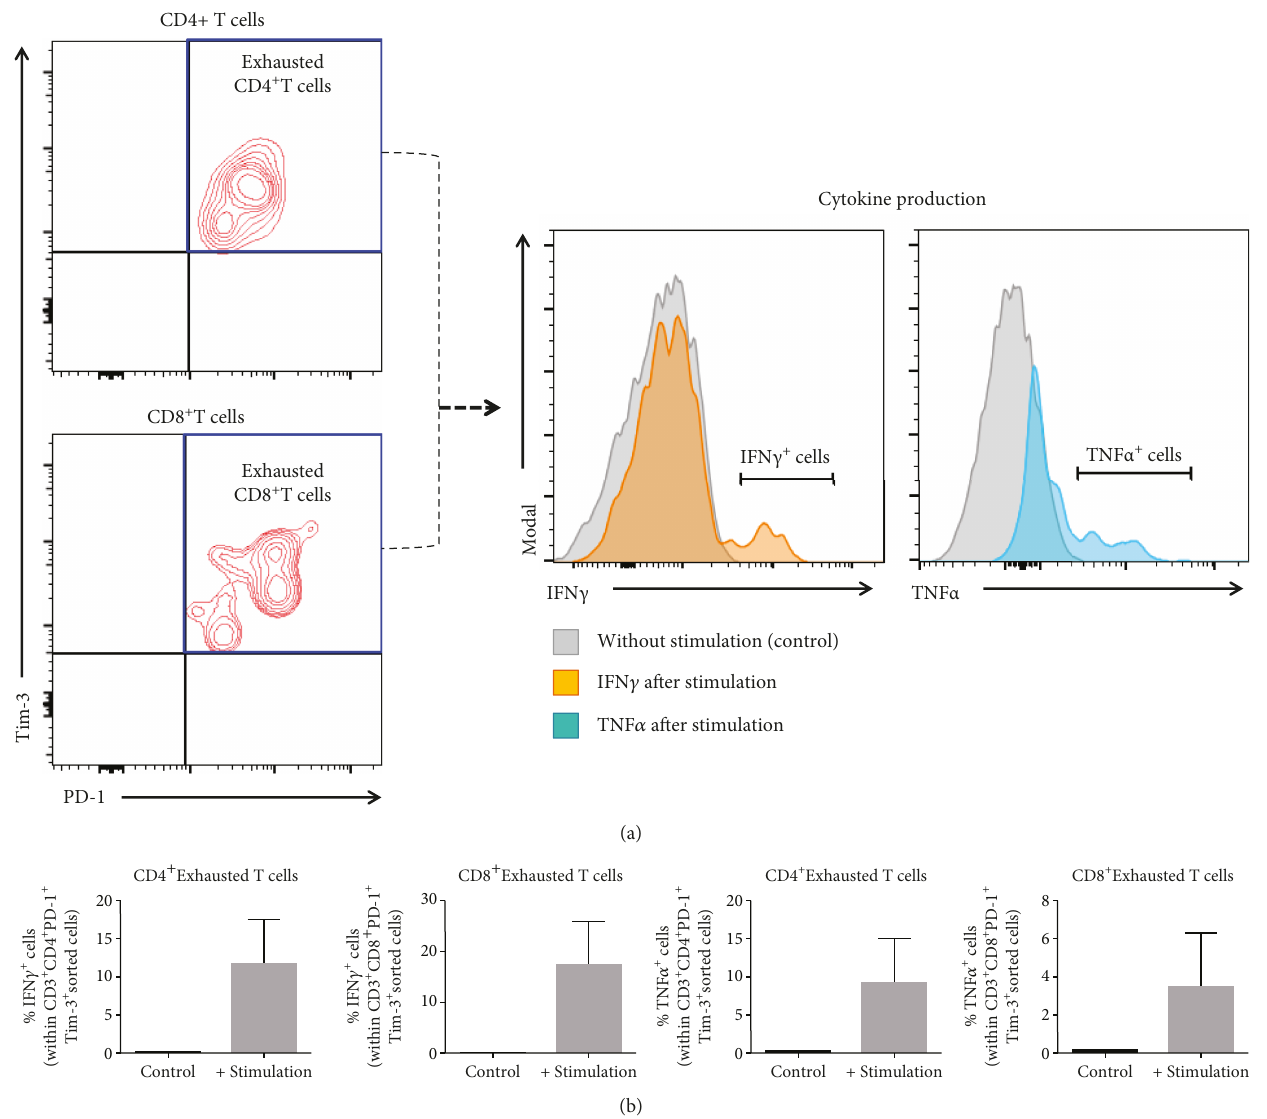
Figure 6: Determination of exhausted T cell functionality upon in vitro stimulation. (a) Gating strategy used to determine the purity of sorted CD4 + and CD8 + exhausted decidual T cells. Histograms show the production of IFN γ (orange histogram) and TNF α (blue histogram) by sorted exhausted T cells after in vitro stimulation. Grey histograms indicate nonstimulated controls. (b) Proportions of sorted exhausted CD4 + and CD8 + decidual T cells expressing IFN γ or TNF α after in vitro stimulation compared to nonstimulated controls. N = 3 . Data are shown as the means with a standard error of the